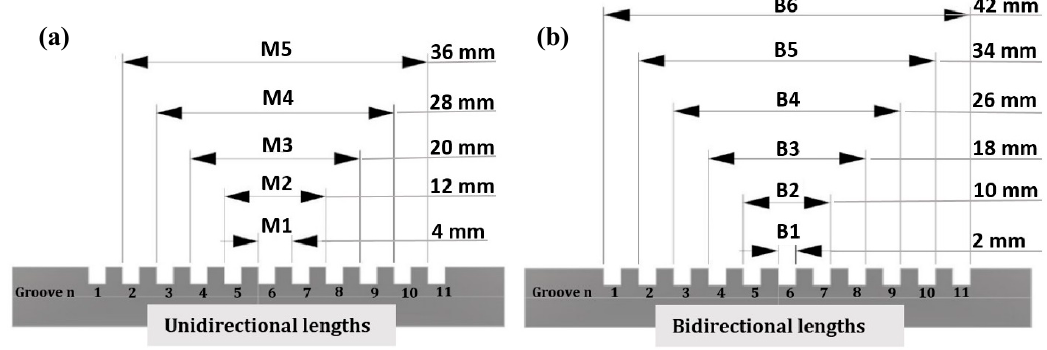
Figure 4. Unidirectional ( a ) and bidirectional ( b ) nominal lengths selected for the analysis.